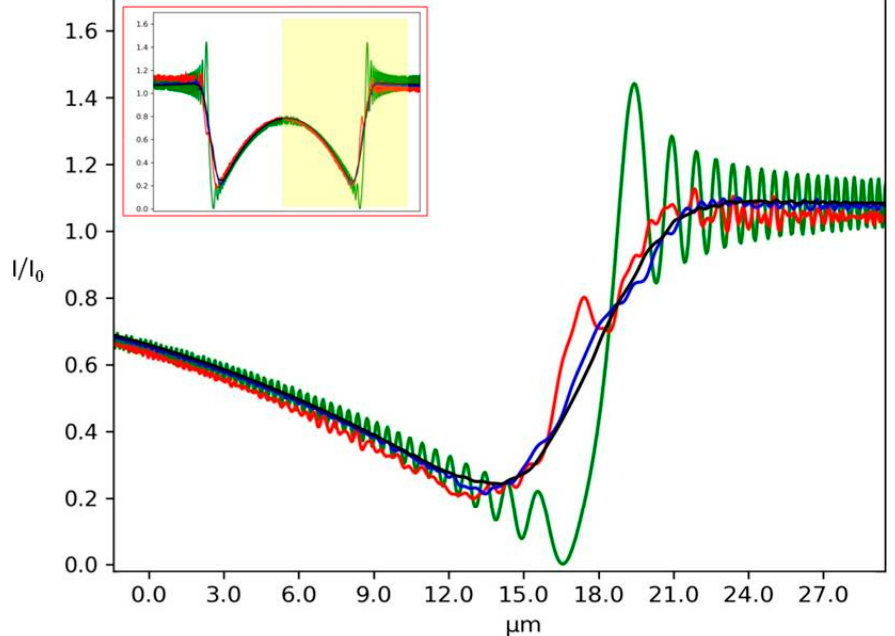
Figure 5. Single line plot of the 2D images displayed in Figure 4. Green line ( N = 1) represents the case of fully coherent illumination, while the red line is for N = 10, the blue for N = 100 and the black for N = 1000. The inset shows the full line